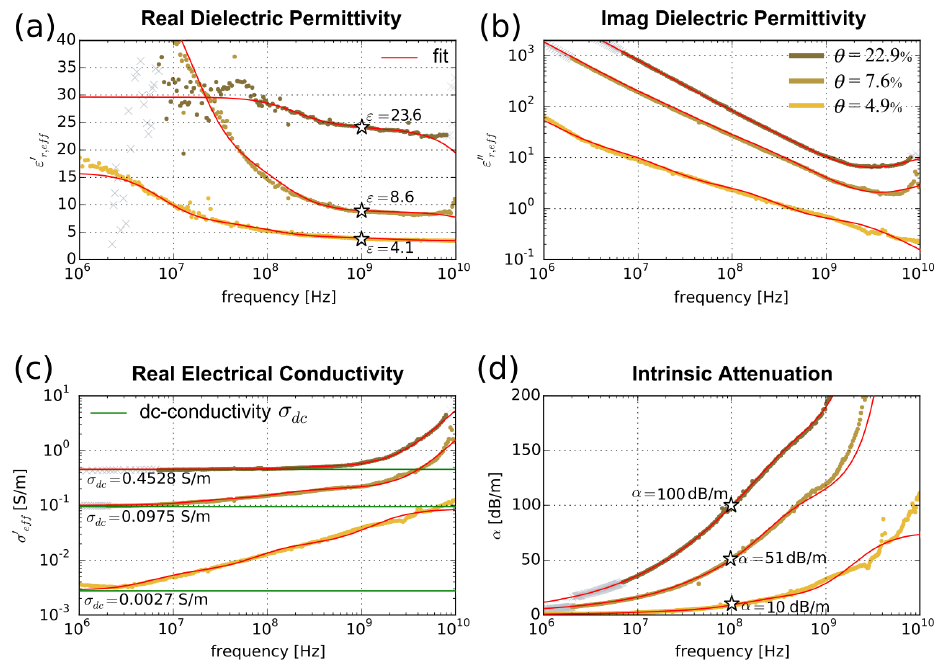
Figure A3. Results of electromagnetic laboratory tests on alluvium samples for three different moistures θ . (a) Real part of dielectric permittivity ε . (b) Imaginary part of dielectric permittivity ε . (c) Direct-current conductivity σ dc . (d) Attenuation α . The results show that attenuation in the moist alluvial material is high due to high DC conductivity. For dry alluvium damping is comparably low. (cid:113) 2 ρ A space can be approximated to δ = (Jol, 2009) with ωµ µ = µ r µ 0 = ∼ 1 · 12 . 57 × 10 − 7 NA − 2 as the magnetic